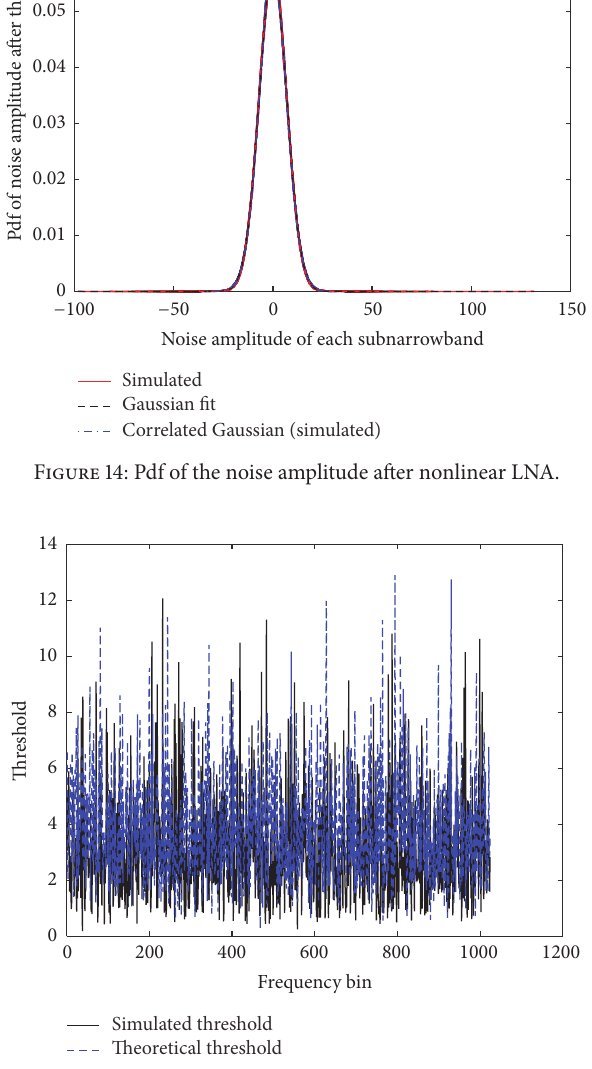
Figure 15: Approximation of simulated threshold value with multi- variate Gaussian